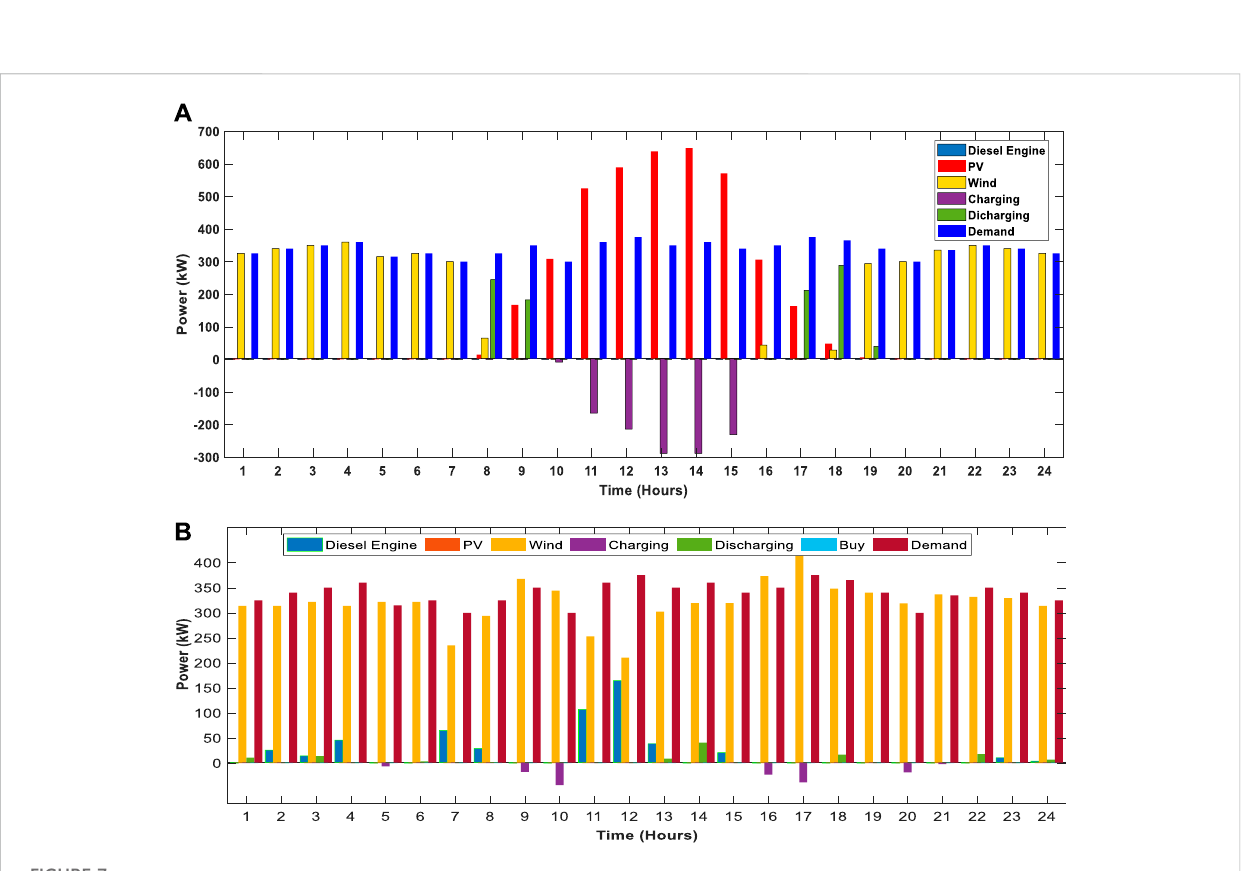
FIGURE 7 Power output curve meeting load demand on a typical day. (A) Stand-alone mode. (B) Grid-connected